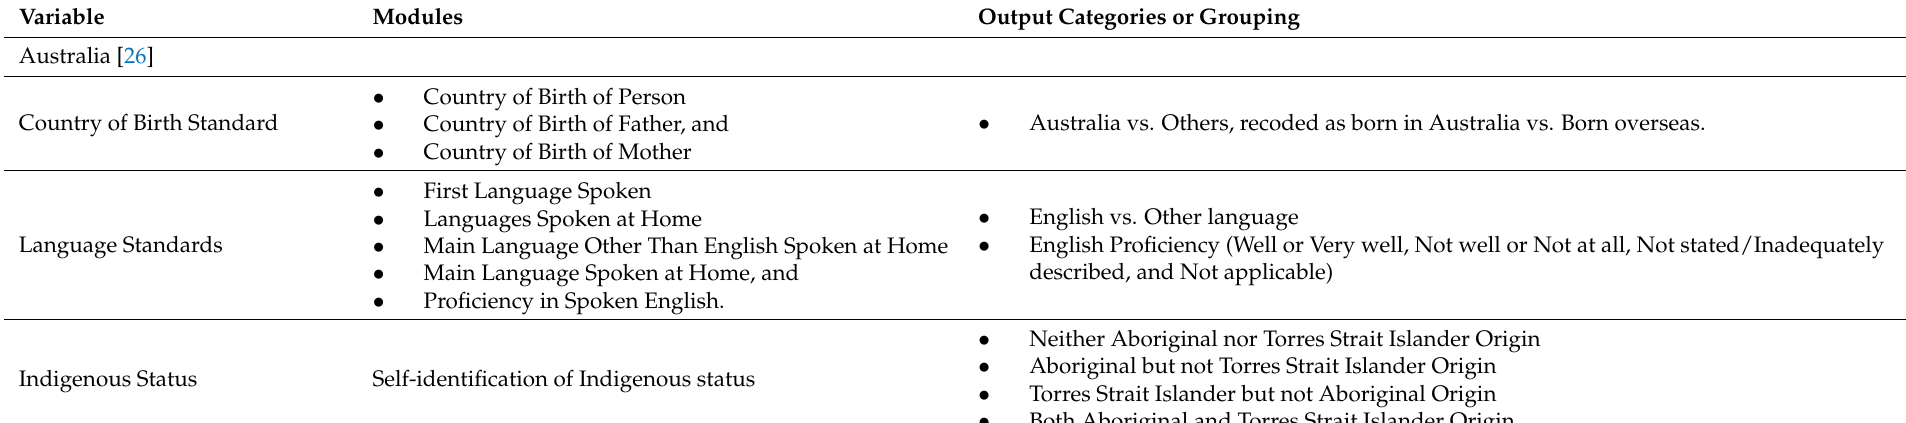
Table 1. Operationalisation of race and ethnicity data in censuses in Australia, Canada, the United Kingdom, and the United States of